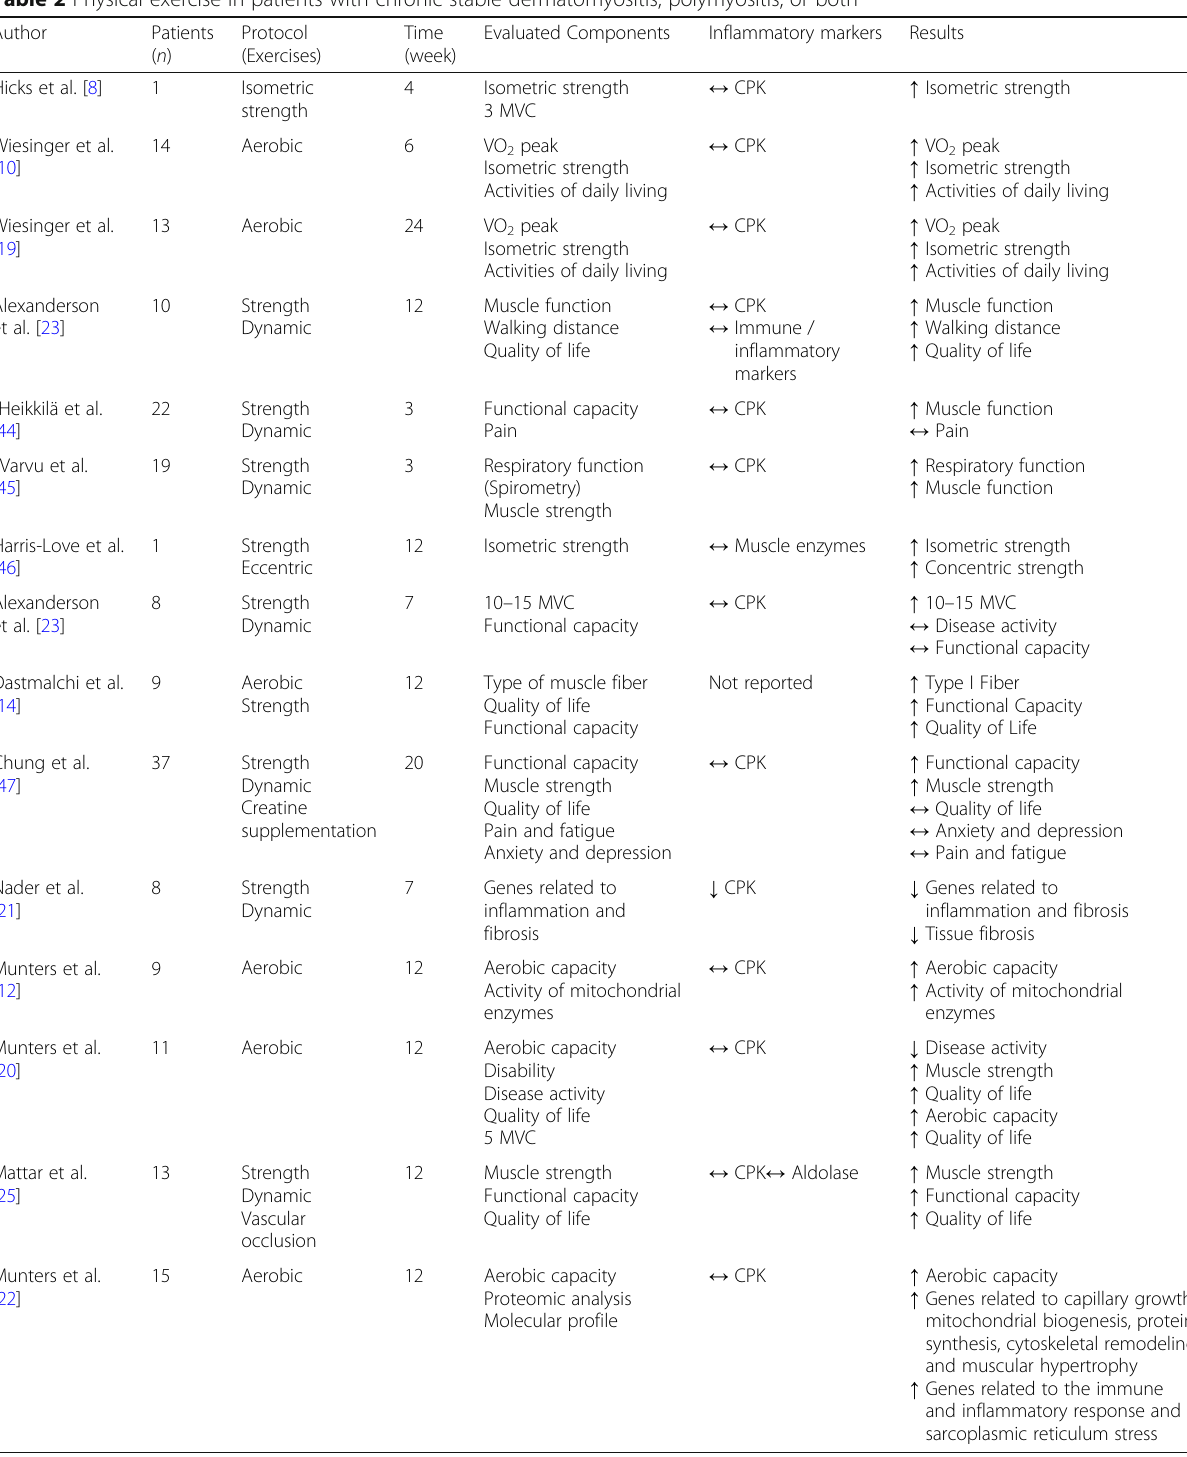
Table 2 Physical exercise in patients with chronic stable dermatomyositis, polymyositis, or both